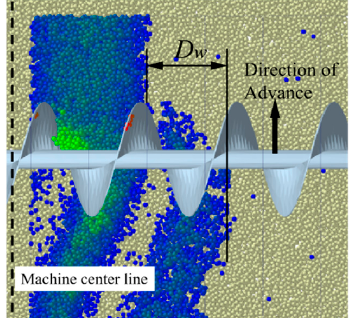
Figure 6. Evaluation index of soil separation distance.